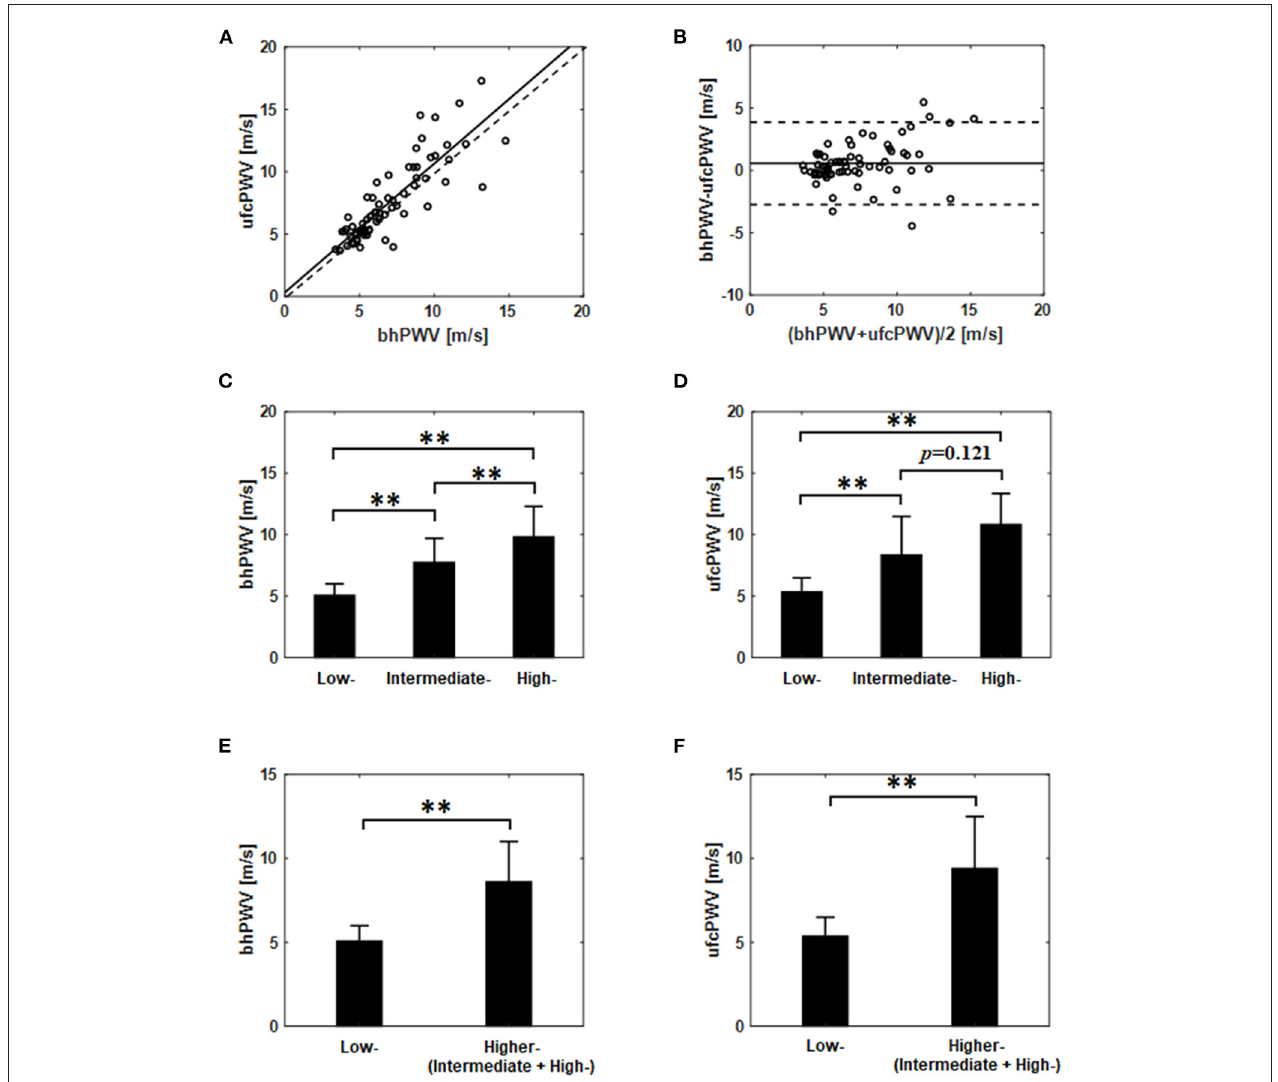
FIGURE 2 | (A) Correlation and (B) agreement assessment between the ufcPWV based on the ultrafast curved array imaging and the bhPWV measured via Bramwell-Hill equation (solid line indicates the mean difference between the two measurements and dashed lines represent mean ± 1.96SD). Comparisons between the three evaluation groups [i.e., low- ( < 10%), intermediate- (10 ∼ 20%) and high-risk ( > 20%)] based on Framingham risk score from (C) the bhPWV and (D) the ufcPWV measurement. Comparisons between the two evaluation groups [i.e., low- ( < 10%) vs. higher-risk ( ≥ 10%)] from (E) the bhPWV and (F) the ufcPWV measurement. ** indicates p <